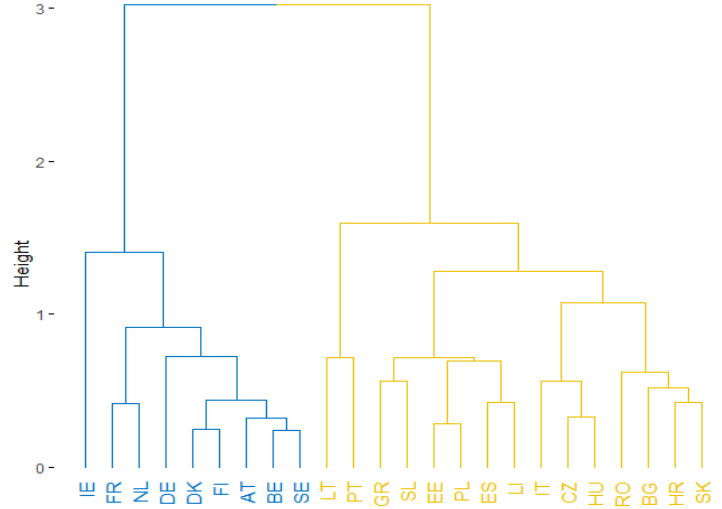
Figure 3. Cluster dendrogram for the “macroeconomic heterogeneity” aspect. Source: Authors’ study based on [75].